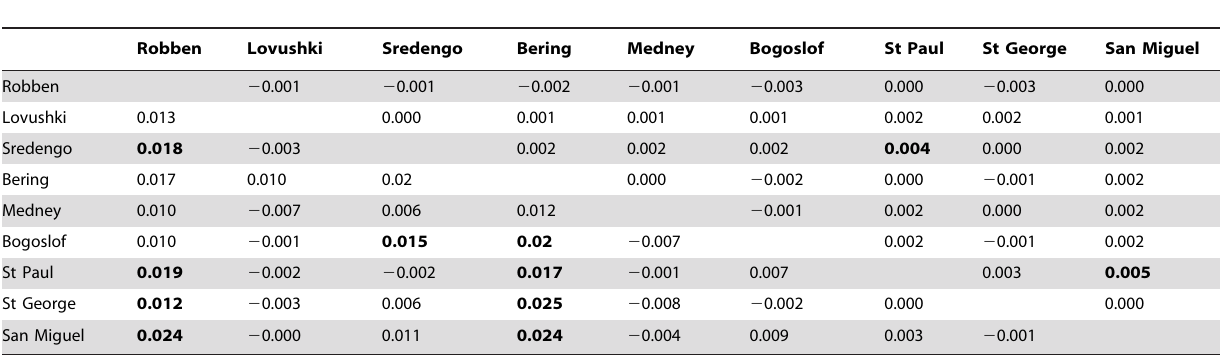
Table 3. Mitochondrial DNA based population differentiation for population pairs (estimates of F ST above diagonal and W ST below